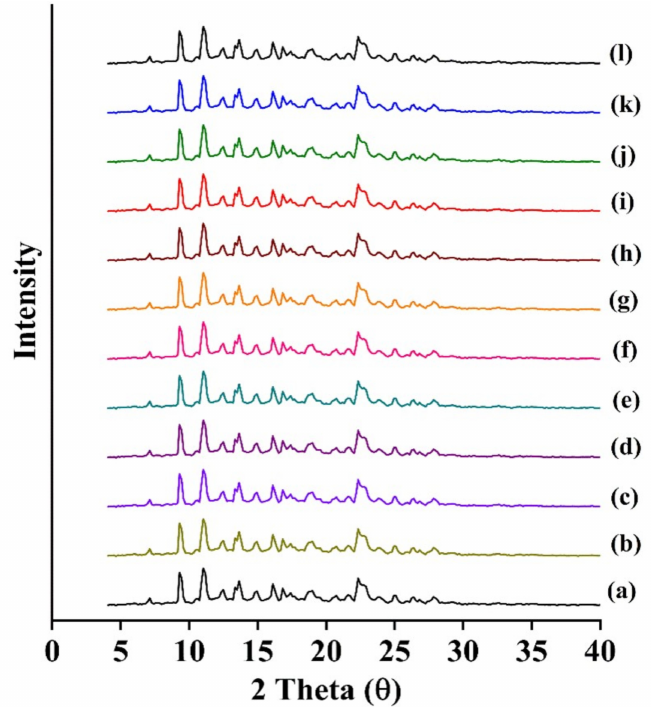
Figure 2. Powder X-ray diffraction (PXRD) patterns of the model drug alone ( a ), the drug—recovered from water ( b ), methanol ( c ), ethanol ( d ), 1-propanol ( e ), 2-propanol ( f ), 1-butanol ( g ), 2-butanol ( h ), acetonitrile ( i ), acetone ( j ), ethyl acetate ( k ), and Transcutol ® HP (THP) ( l